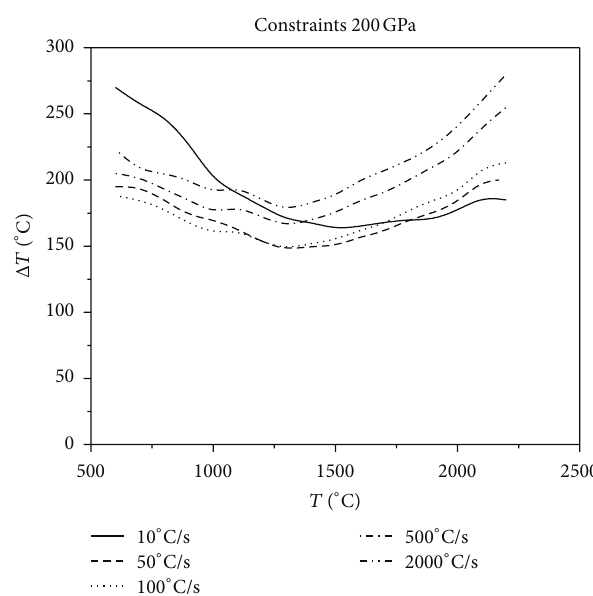
Figure 12: Relationship between critical fracture temperatures corresponding to different cooling rates and thermal shock initial temperatures under the constraints of 200